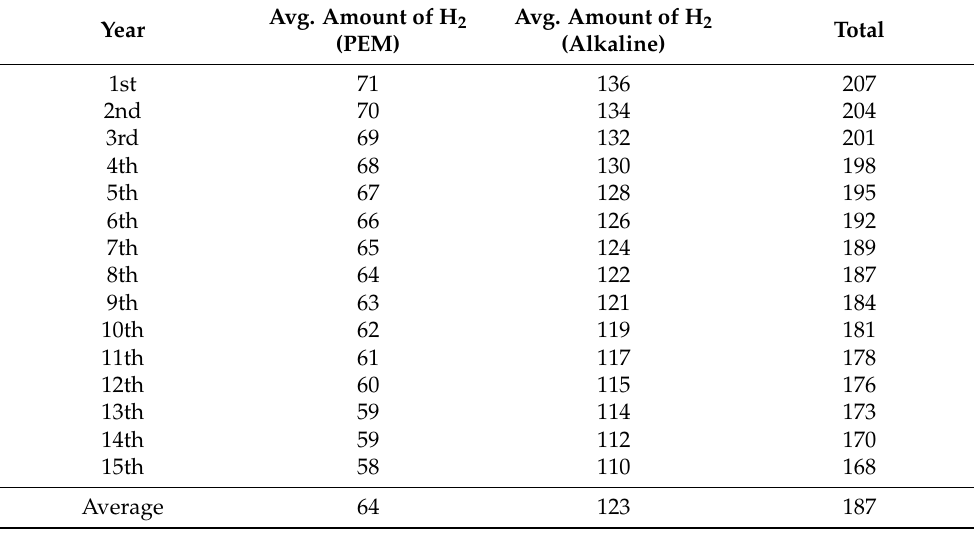
Table 27. The average daily amount of hydrogen produced for each year (Scenario